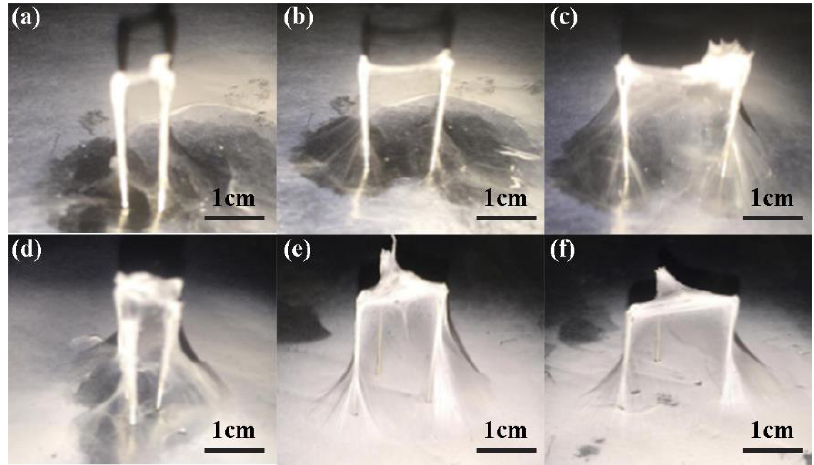
Figure 4. 3D nanofibrous structure printed on probe arrays with different intervals; ( a ) 5 mm, ( b ) 10 mm, and ( c ) 15 mm of 2 probes; ( d ) 5 mm, ( e ) 10 mm, and ( f ) 15 mm of 3 probes. The probe height, the flow rate, and the applied voltage were 10 mm, 300 μL/ h, and 20 kV, respectively.